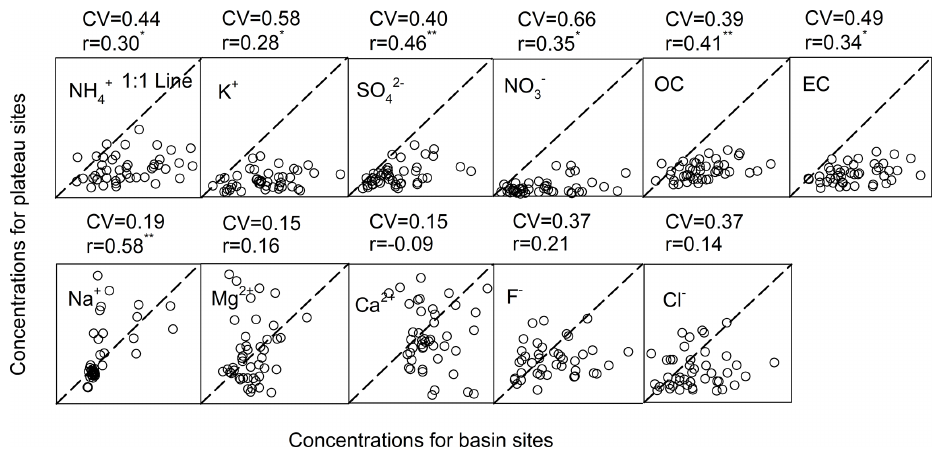
Figure 9. Relationships of PM 1 chemical components concentrations in spring between basin (horizontal axes, including Chengdu and Sanbacun) and plateau sites (vertical axes, including Wenchuan, Lixian, Maerkang and Hongyuan). The correlation coefficients ( r ) with asterisk and double asterisk superscripts passed the significance level of 0.05 and 0.01,